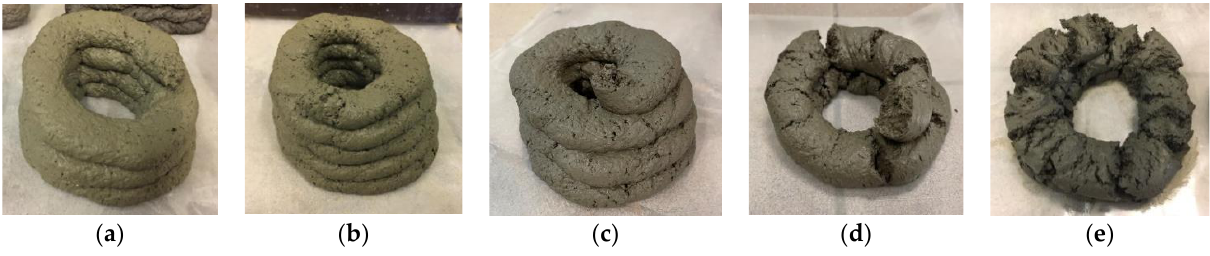
Figure 5. Printing using the manual gun device of ( a ) REF; ( b ) FS5; ( c ) FS10; ( d ) FS20; and ( e ) FS30.